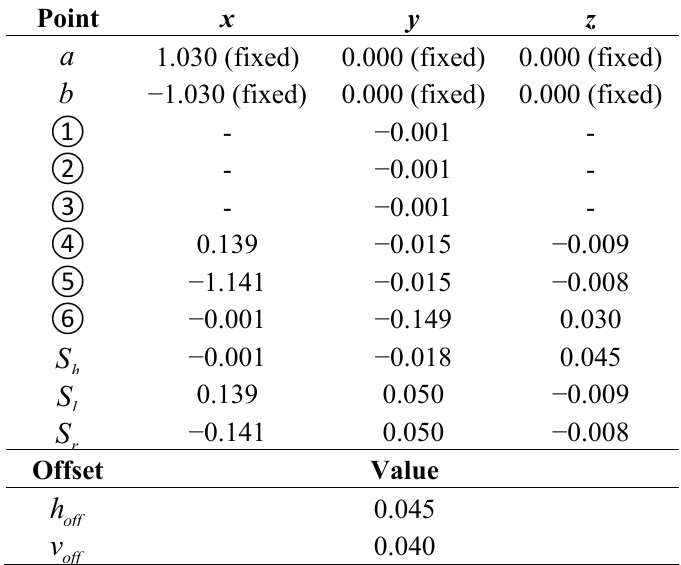
Table 1. Alignment results with respect to the temporary coordinate system (unit: M).